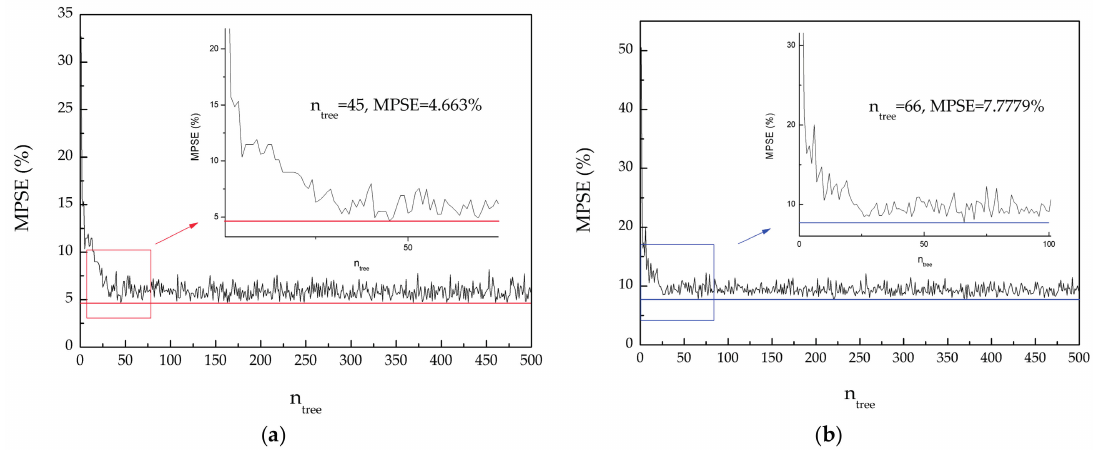
Figure 3. Forecasting the OOB error of RFs with different n tree . ( a ) The change in MPSE of ESDD when n tree changes; ( b ) The change in MPSE of NSDD when ntree changes.